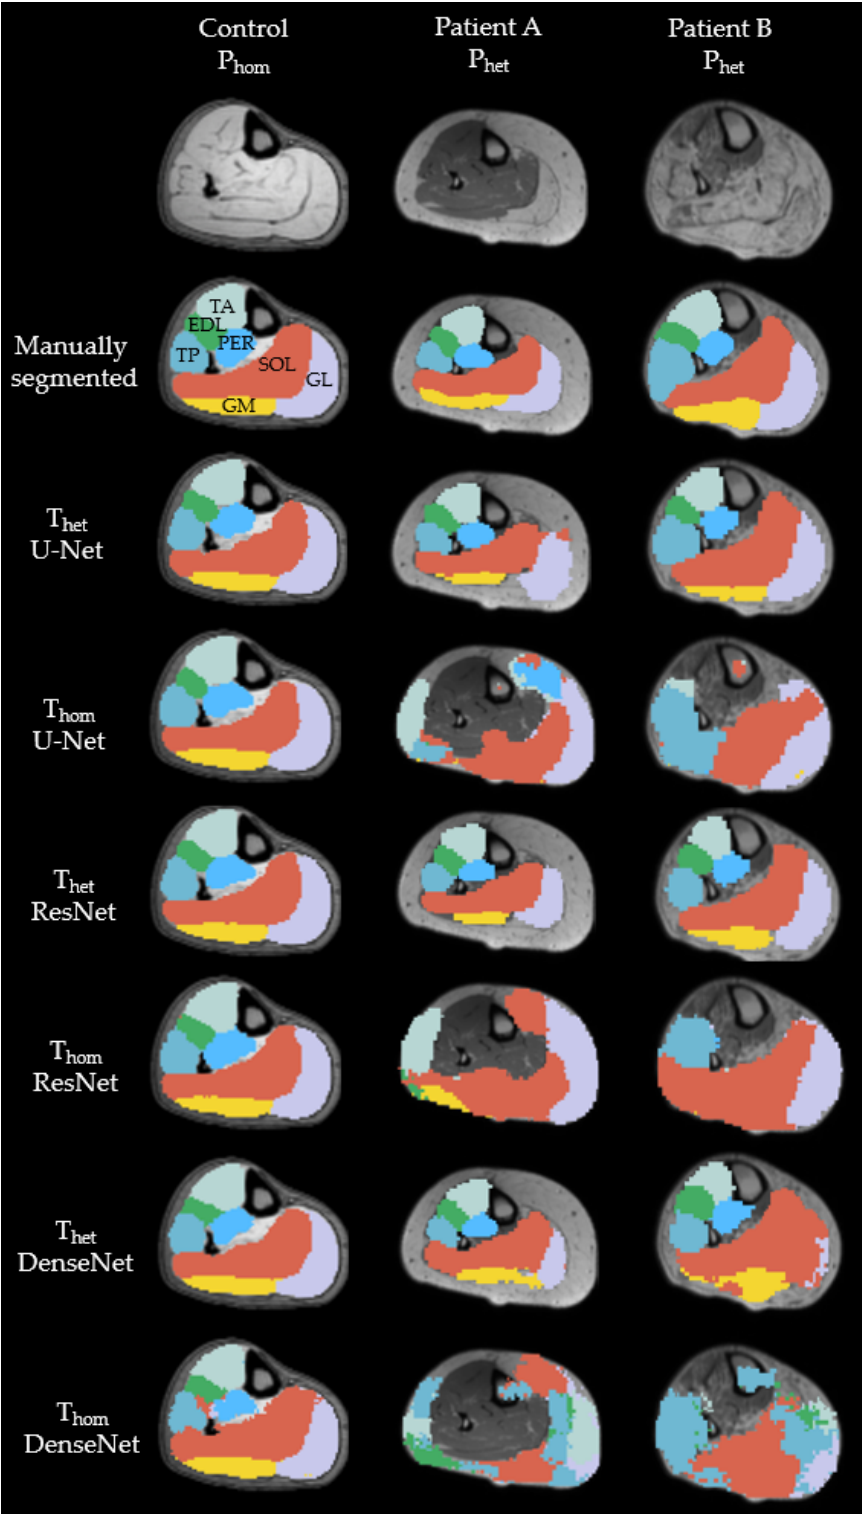
Figure 3. Examples of cross-sectional segmentation overlaid with MR-images of one representative healthy control and two different patients. Each column represents a different network, trained on either a heterogenous or homogenous dataset. EDL = extensor digitorum longus (green); GL = gastrocnemius lateralis (purple); GM = gastrocnemius medialis (yellow); PER = peroneal group (light blue); SOL = soleus (orange); TA = tibialis anterior (mint); TP = tibialis posterior (blue). As an example, Figure 4 shows an overlay of a manually segmentation and a ResNet- predicted-label.